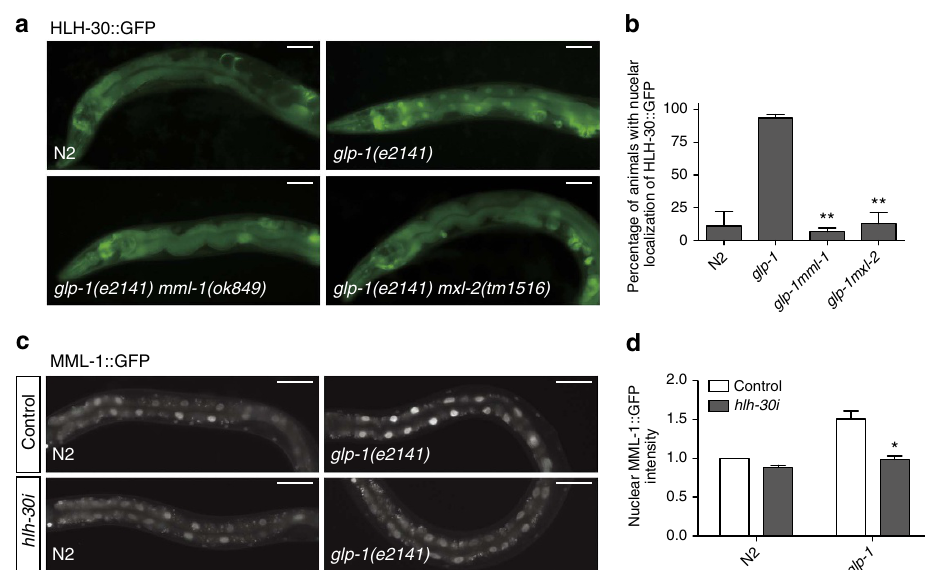
Figure 3 | Mutual regulation of MML-1 and HLH-30. ( a ) Representative fluorescent images showing HLH-30::GFP expression in day 1 young adult worms of indicated genotypes. Worms were raised at non-permissive temperatures (25 (cid:2) C) for glp-1 . Nuclear localization of HLH-30::GFP in glp-1 is abolished in glp-1mml-1 and glp-1mxl-2 animals. ( b ) Percentage of worms with HLH-30::GFP in the nuclei of intestinal cells at day 1 young adult stage (mean ± s.e.m. from 3 biological replicates, 4 20 worms each, ** P o 0.01, t -test relative to glp-1 ). ( c ) Representative fluorescent images of MML-1::GFP transgenic worms in N2 and glp-1 background fed with control L4440:: luc RNAi or hlh-30 RNAi. Upregulation of nuclear MML-1::GFP in glp-1 is abolished on hlh-30 knockdown. ( d ) Nuclear MML-1::GFP intensity relative to N2 fed with control RNAi (mean ± s.e.m. from 3 biological replicates, 4 20 worms each, * P o 0.05, t -test relative to glp-1 fed with control RNAi). Scale bars, 50 m